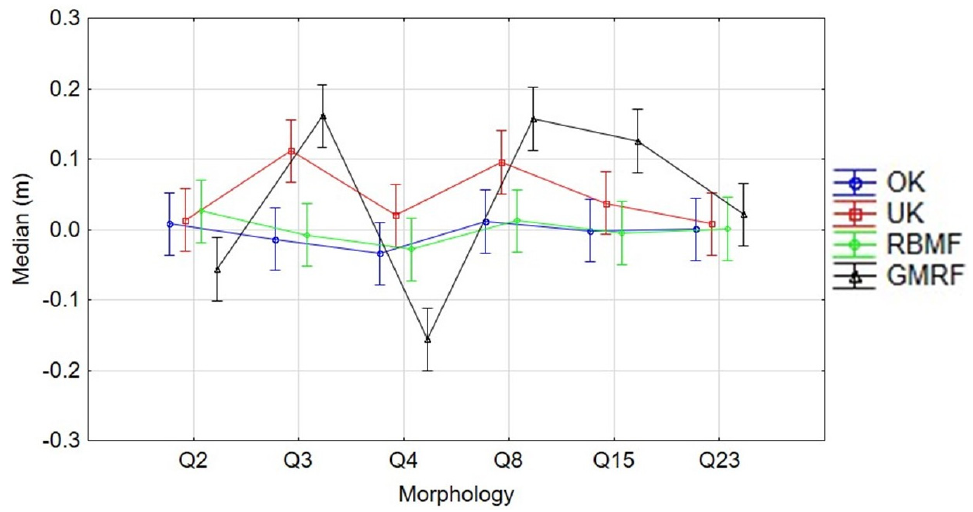
Figure 11. Trend graph of the median of the residuals (Z interpolated − Z checkpoint ) with respect to the interaction between Morphology and Interpolation Method. Vertical bars denote 95% con fi dence intervals.